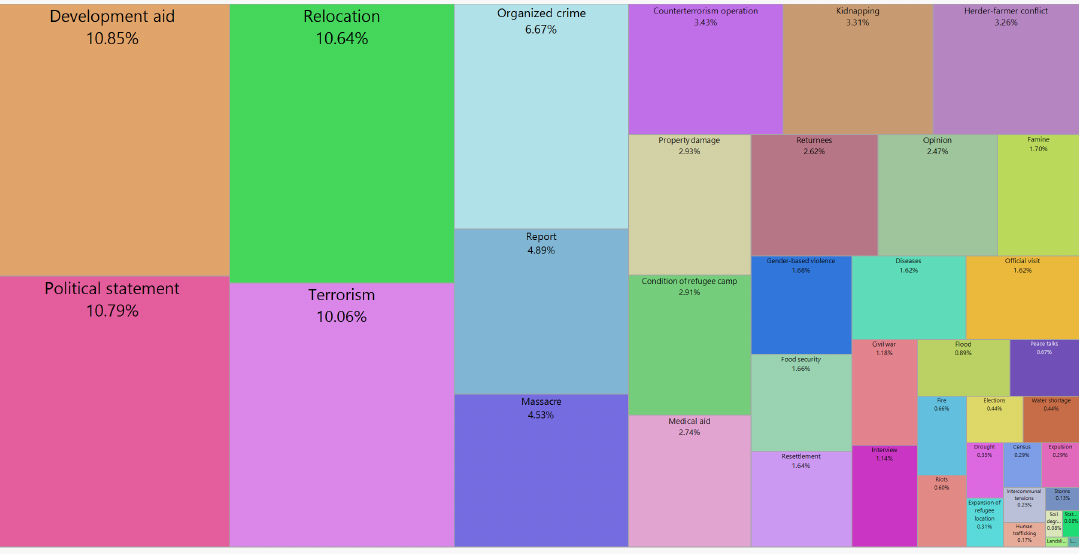
Figure 3. An excerpt of the thematic classes found in the news articles aggregated over the 6-month period considered in the study and